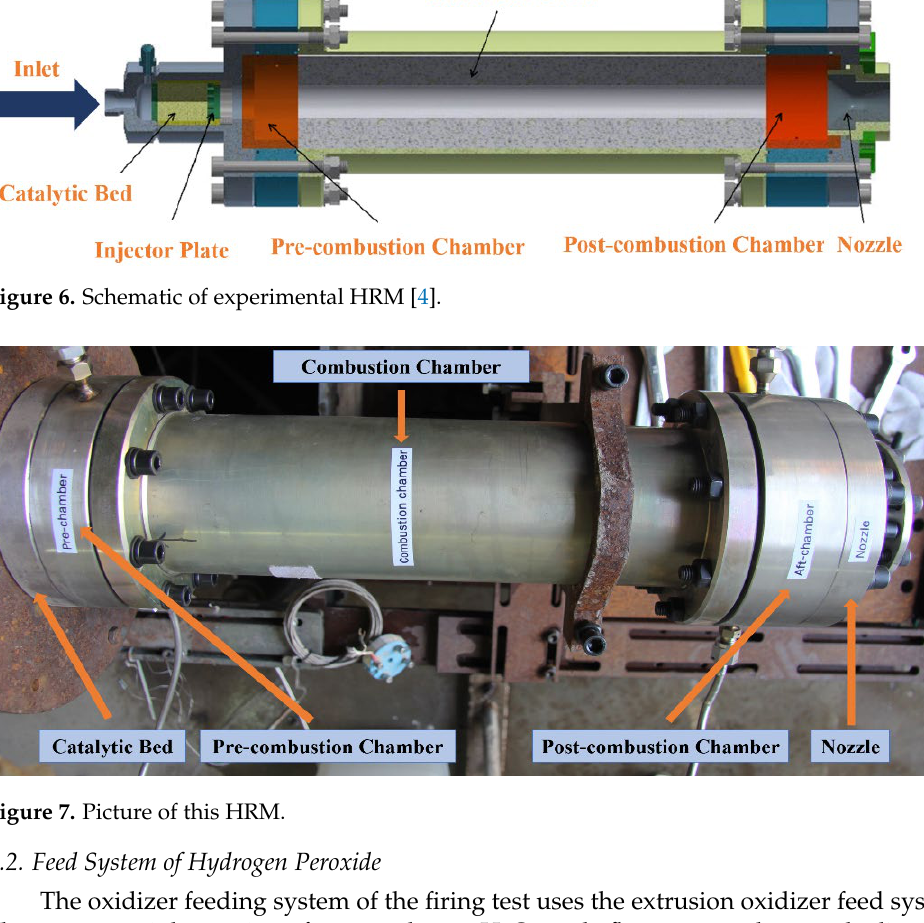
Figure 7. Picture of this HRM.